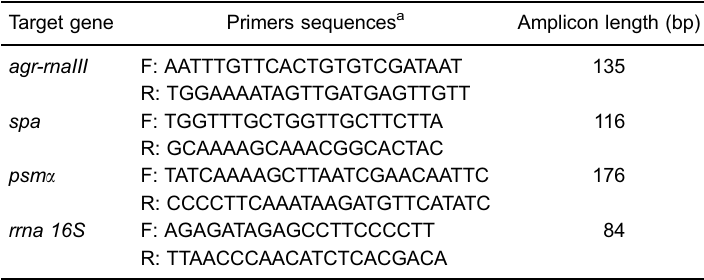
Table 1. Primers used in the real-time RT-qPCR